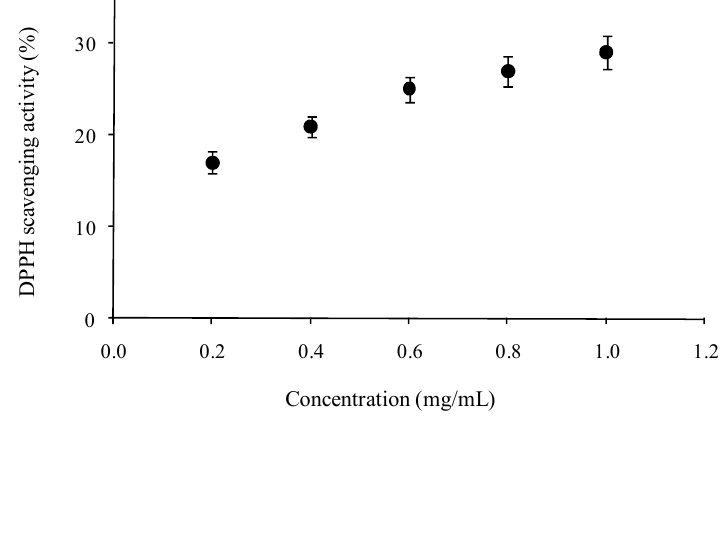
Figure 2. Scavenging activity of Cicer arietinum L. pectin against DPPH radicals. Each value is presented as mean ± standard error (n =